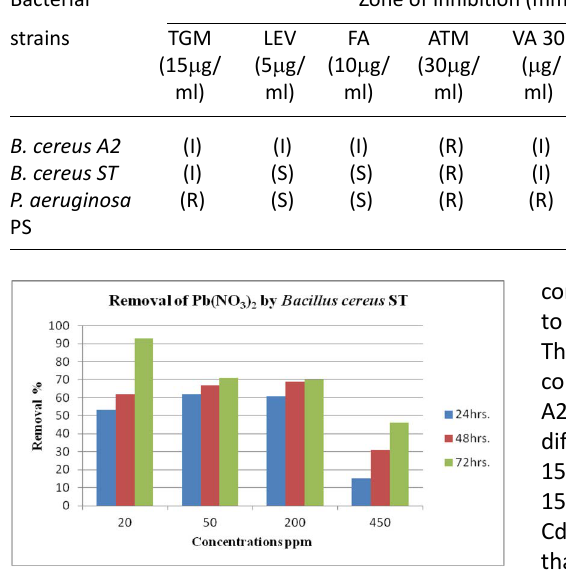
Table 8. Inhibition zone of antibiotic susceptibility of the three bacterial strains: Bacterial Zone of Inhibition (mm)